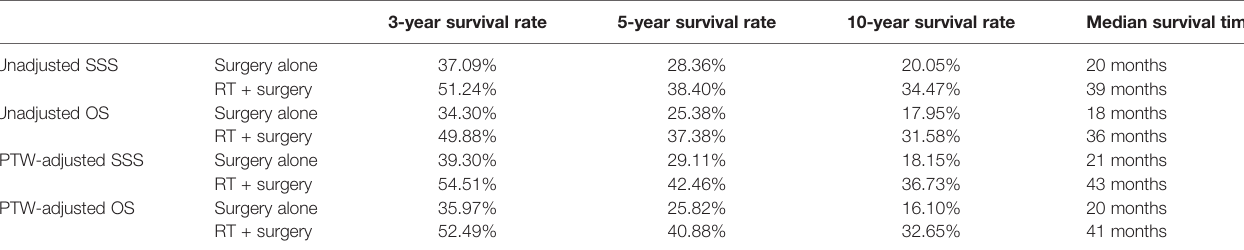
TABLE 2 | Three-year, fi ve-year, ten-year survival rates and median survival time in the unadjusted cohort and IPTW-adjusted cohort.